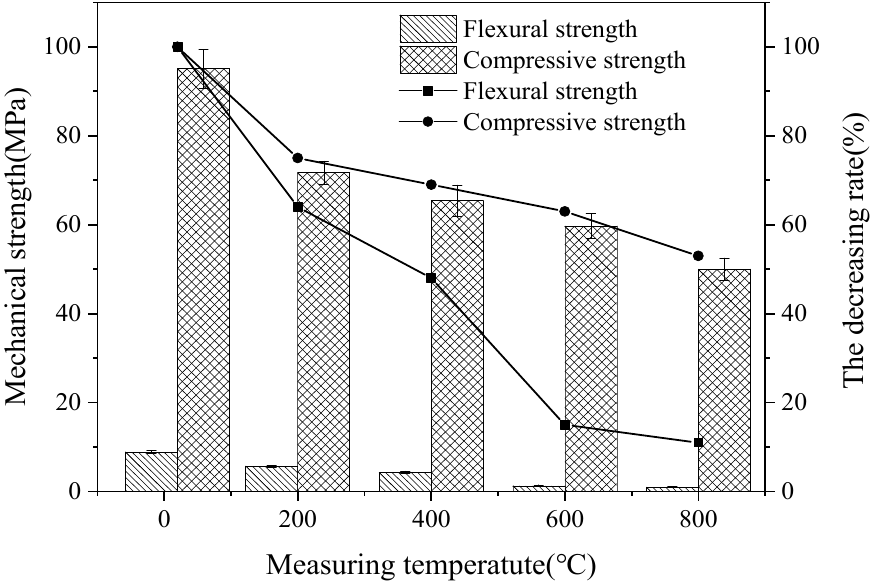
Figure 10. The mechanical strength with different testing temperature.